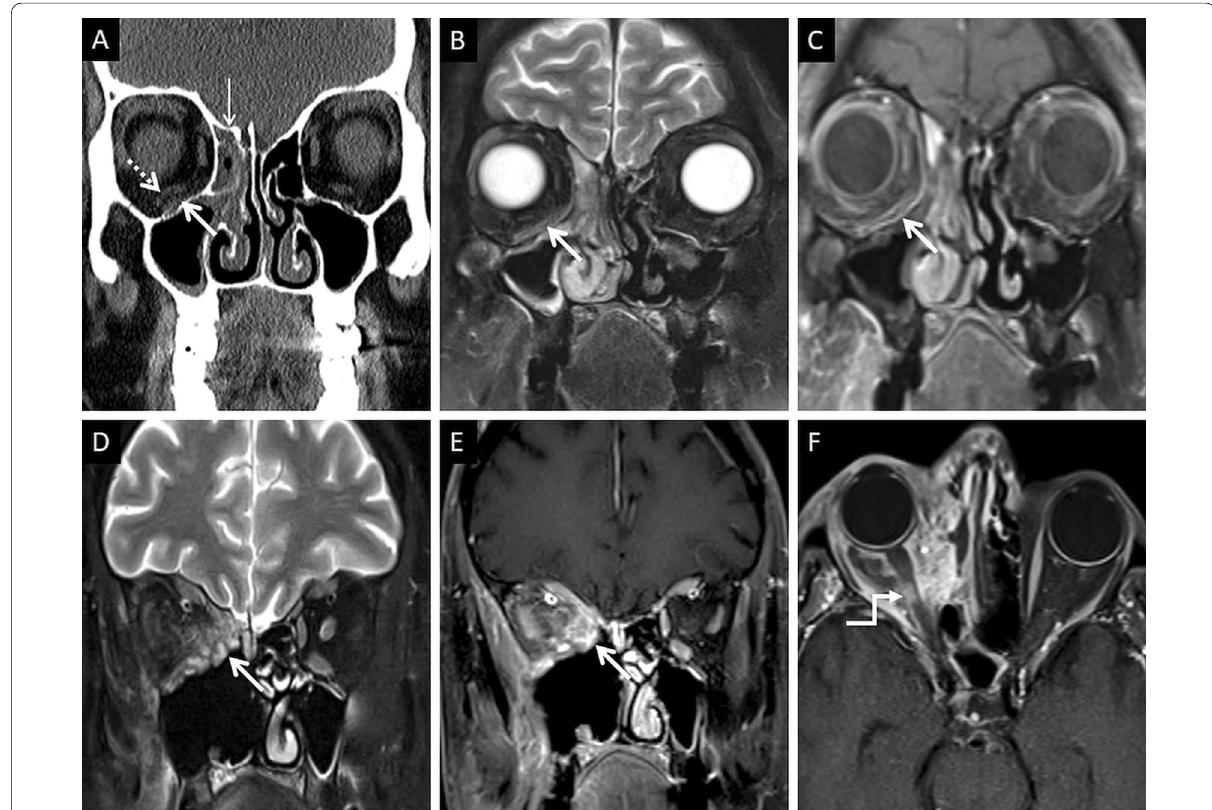
Fig. 13 Orbital spread in a patient with histopathologically and microbiologically confirmed ROCM. Coronal CT image of the paranasal sinuses ( a ), obtained using the bone algorithm, reveals right ethmoid sinusitis (thin arrow). Note the subtle extra-conal fat stranding (thick arrow) and mild displacement of the right inferior rectus (dotted arrow). Based on the clinical suspicion of ROCM and CT findings a CE MRI was suggested. Coronal T2-FS image ( b ) confirms the soft tissue within the right extra-conal space (thick arrow), detected previously on the CT. CE FS coronal T1W image ( c ) demonstrates heterogeneous enhancement of the soft tissue (thick arrow). The patient underwent surgical debridement along with right turbinectomy and removal of the right lamina papyracae, followed by a post-operative CE MRI ( d – f ) follow-up. Coronal T2-FS ( d ) reveals worsening of the disease with a confluent soft tissue (thick arrow) involving the orbital fat and the extra-ocular muscles. CE FS coronal T1W image ( e ) reveals intense enhancement of the right orbital soft tissue (thick arrow). CE FS axial T1W image ( f ) reveals focal fungal invasion of the right optic nerve (stepped